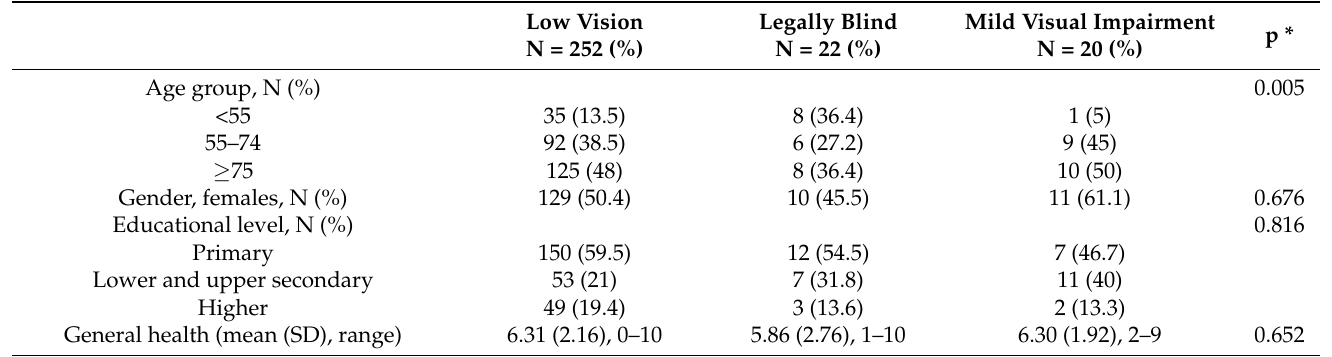
Table 2. Clinical and sociodemographic characteristics of the